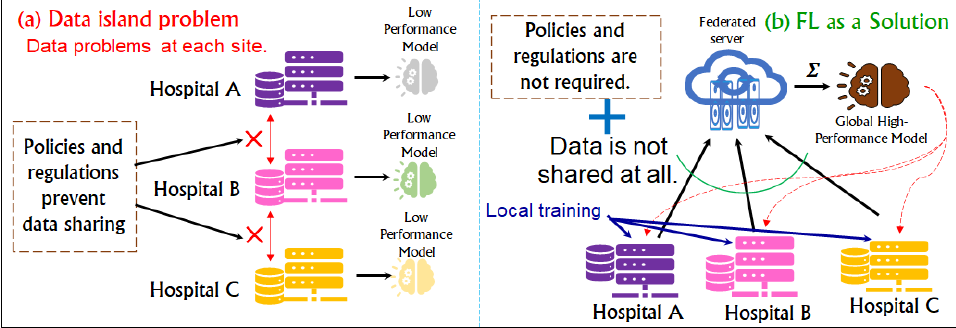
Figure 10. Data island problem, and FL as a promising solution towards this problem. As shown in Figure 10a, all hospitals individually train the model with their data.